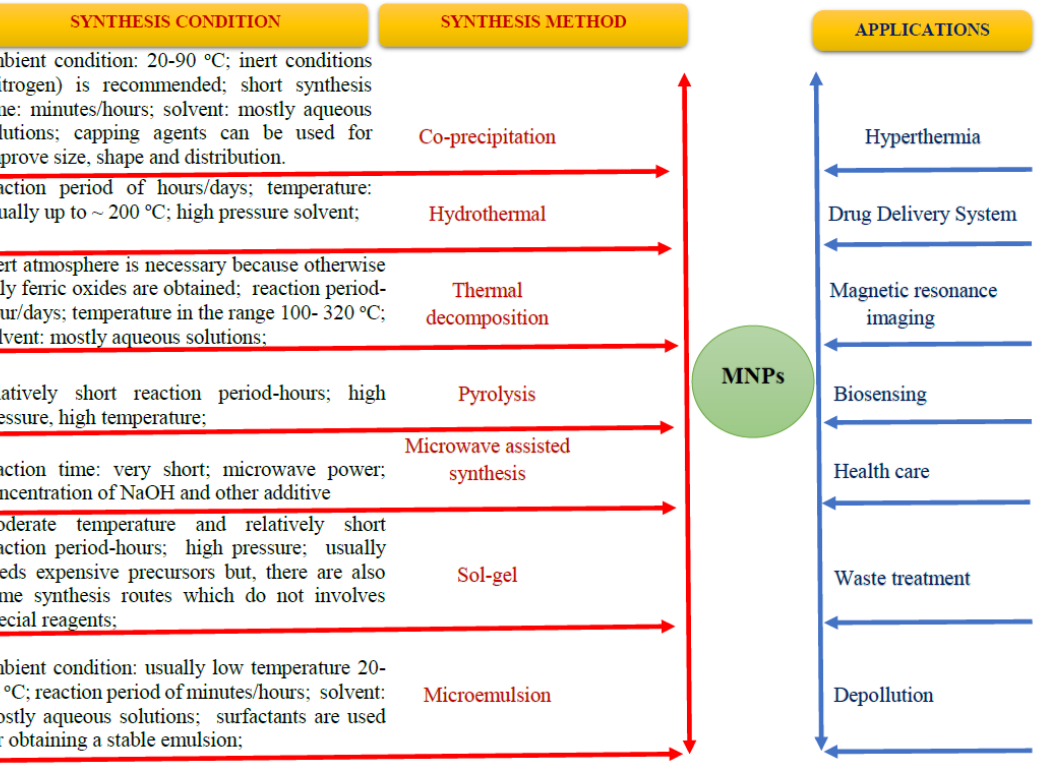
Figure 1. Correlation between synthesis method and application.